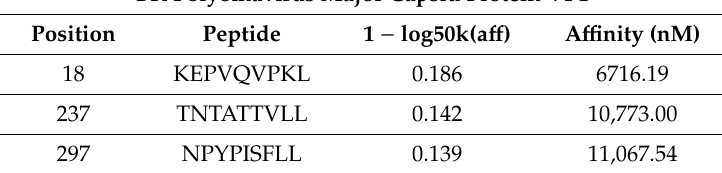
Table 3. High and moderate a ffi nity peptide sequences derived from BKPyV major capsid protein VP1 that may be presented by the HLA-E*01:01 allelic variant as identified by the machine-learning bioinformatics algorithm NetMHC 4.0. Position: residue number (starting from 0); peptide: amino acid sequence of the potential ligand.